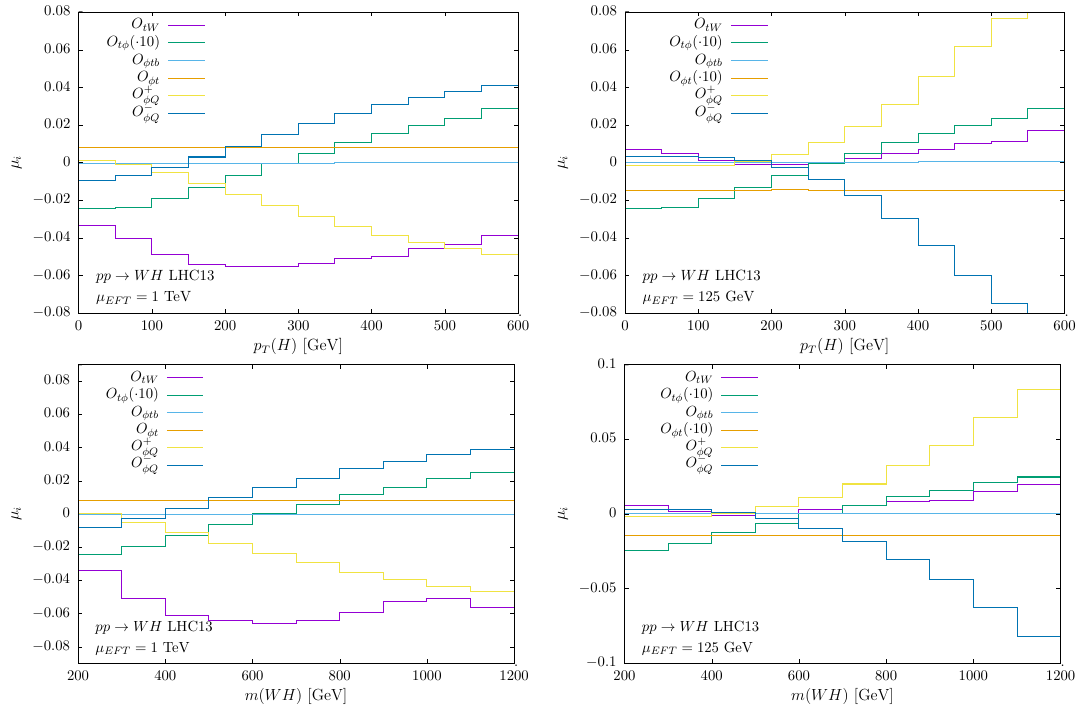
Figure 5 . Sensitivity of the Higgs transverse momentum distribution (top) and WH invariant mass distribution (bottom) in WH production for the di(cid:11)erent operators at (cid:22) EFT = 1000 GeV (left) and (cid:22) EFT = 125 GeV